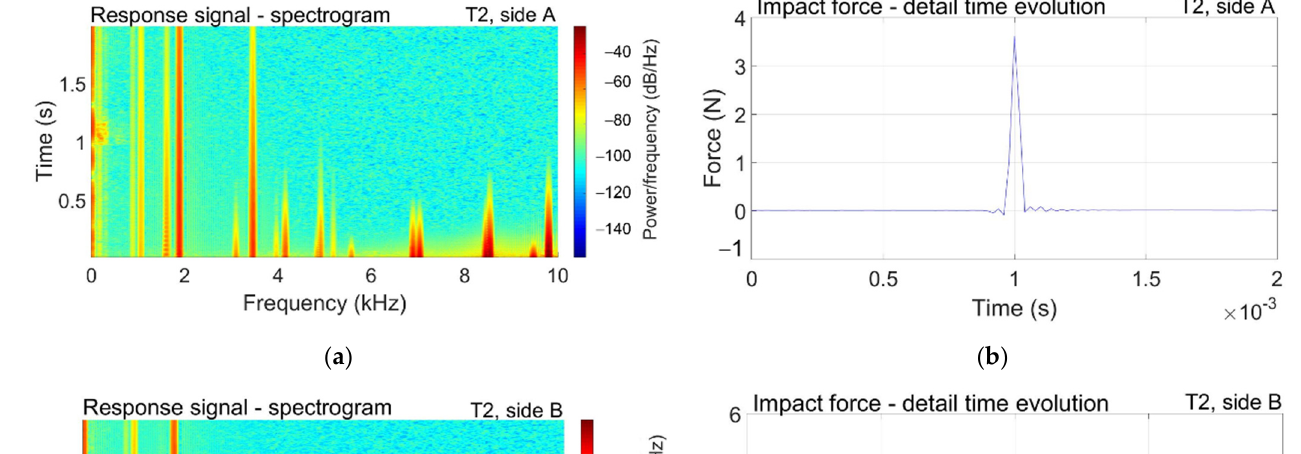
Figure 6. The spectrograms and the graphs of impact force, for stainless steel triangle T1: ( a ) in case of excitation of side A; ( b ) the plot of excitation force against the time, by hitting side A; ( c ) in case of excitation of side B; ( d ) the plot of excitation force against the time, by hitting side B; ( e ) in case of excitation of side C; ( f ) the plot of excitation force against the time, by hitting side C.